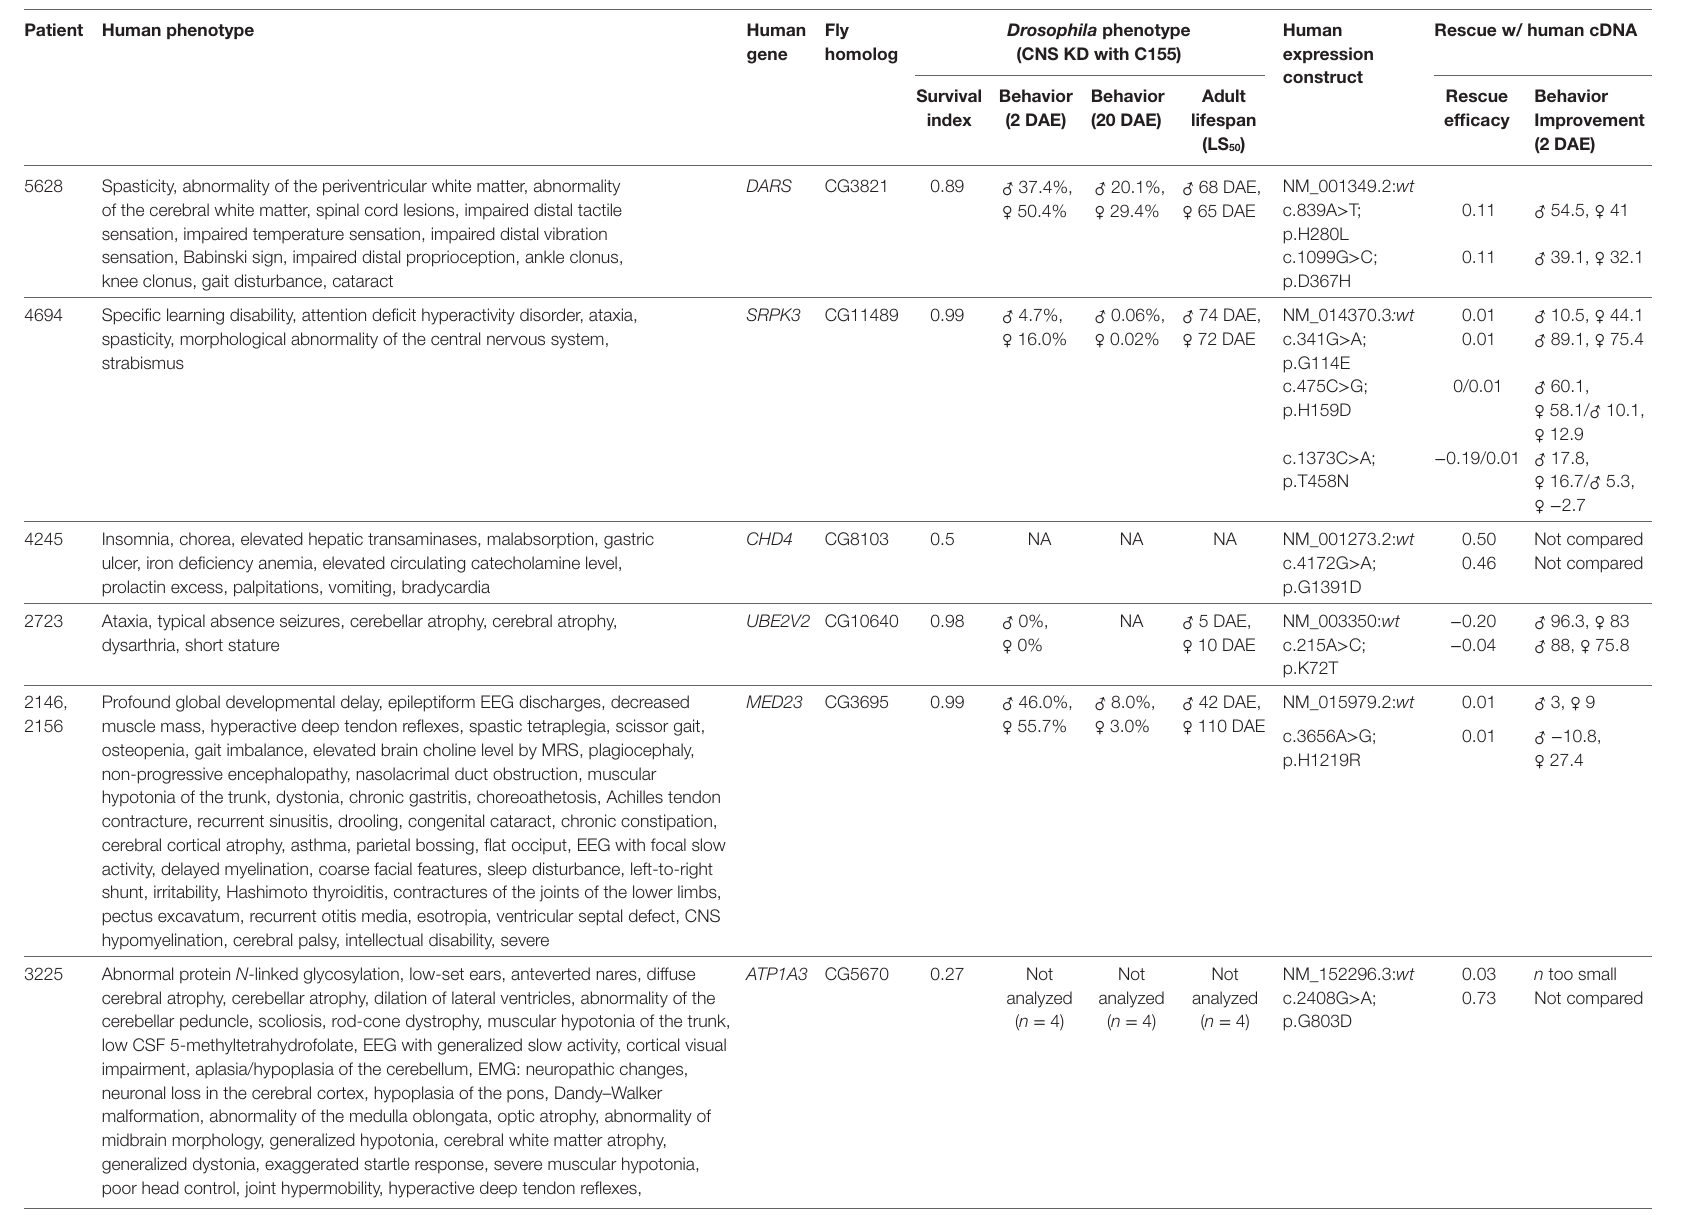
tABLe 1 | Results of Drosophila central nervous system knockdown and rescue for 11 mutations in differing candidate genes. Patient human